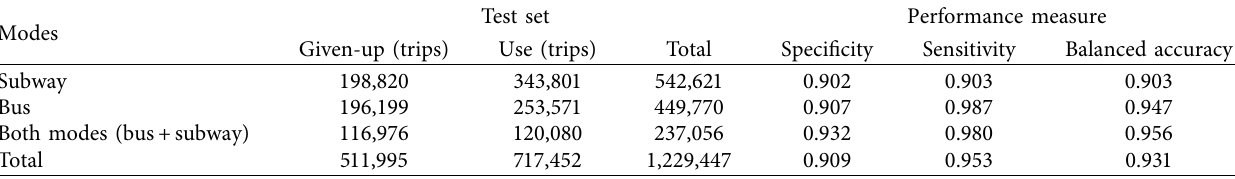
Table 3: Performance of proposed XGB model.